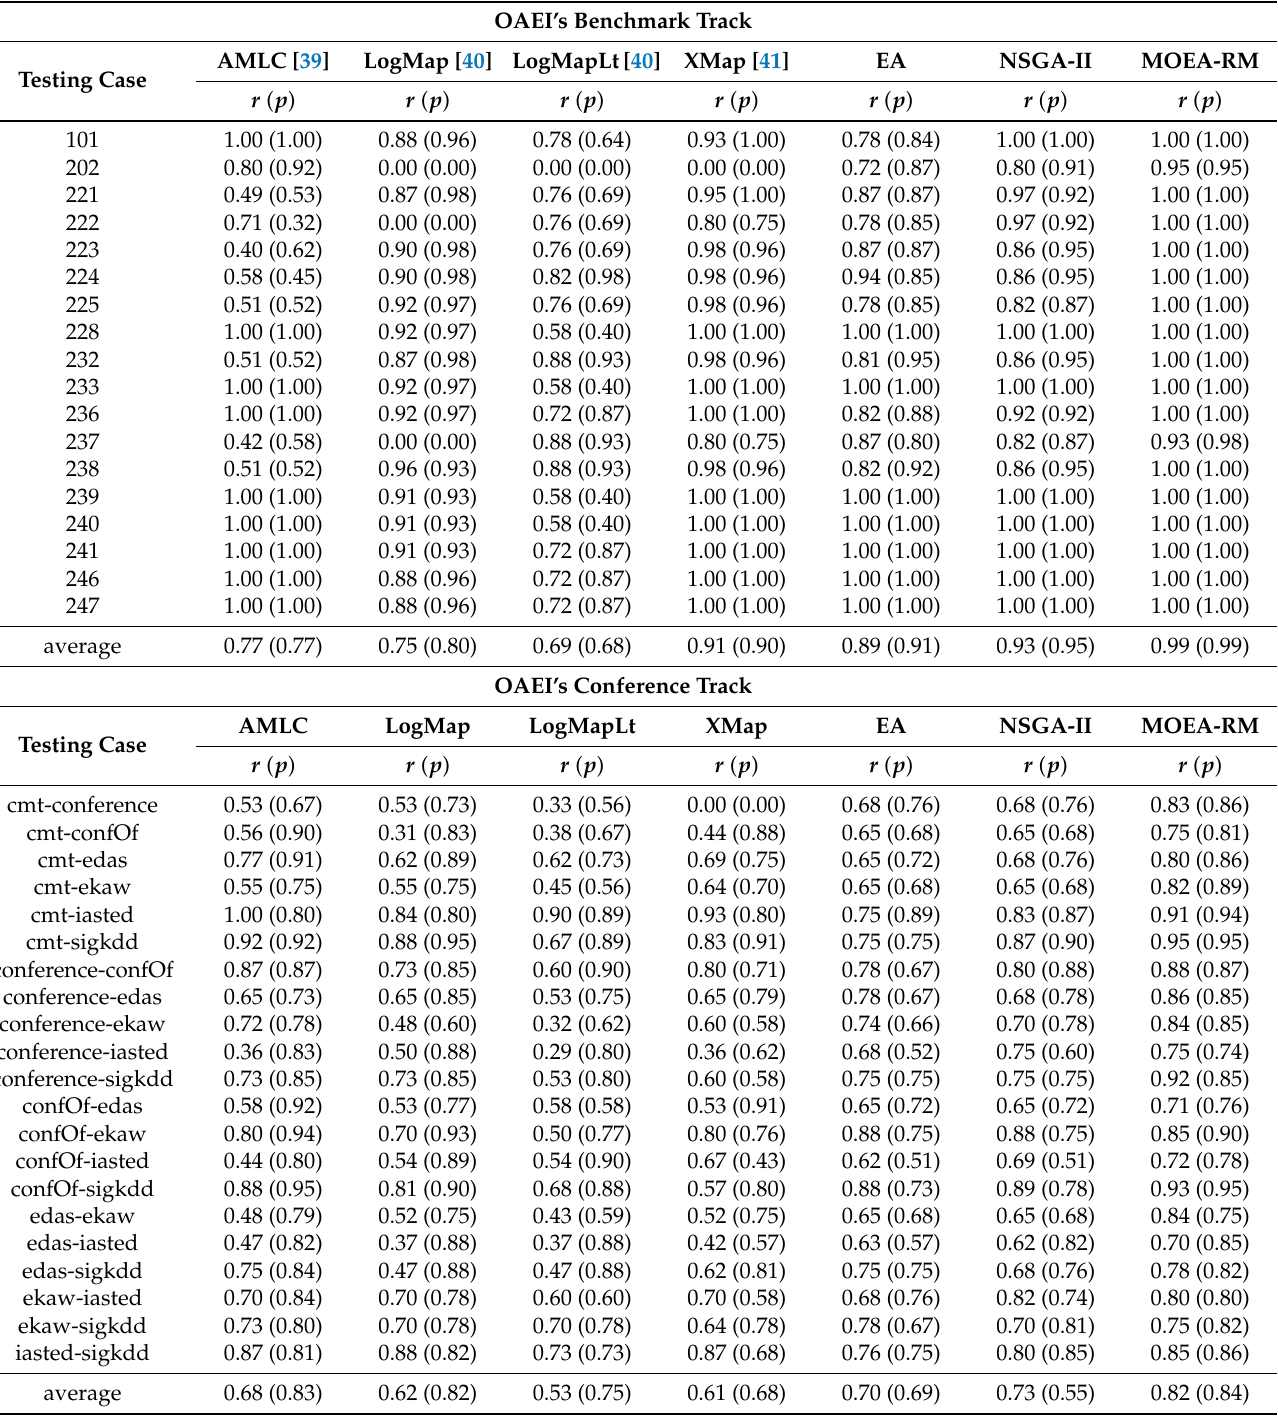
Table 2. Comparison in terms of recall and precision. The symbols r and p respectively denote recall and